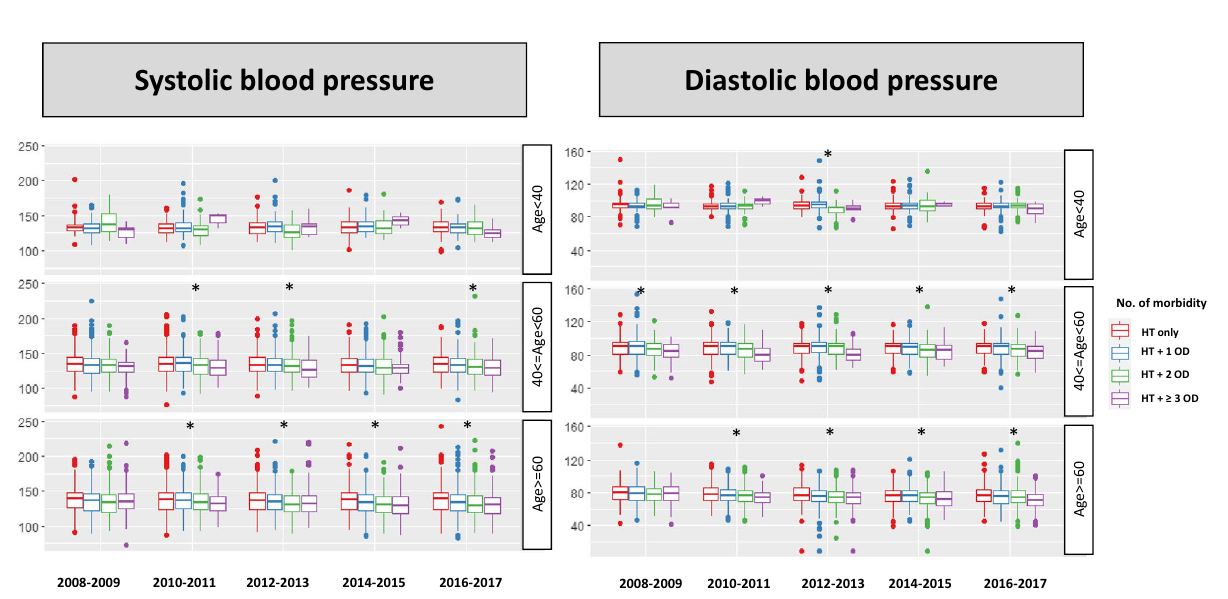
Figure 5. Trends of systolic and diastolic blood pressure in patients with hypertension according to accompanying other medical conditions. Systolic and diastolic blood pressures are inversely correlated with the number of chronic medical conditions among the middle age (40–60 years) and older age (> = 60 years) group. OD other disease, *p < 0.05 by